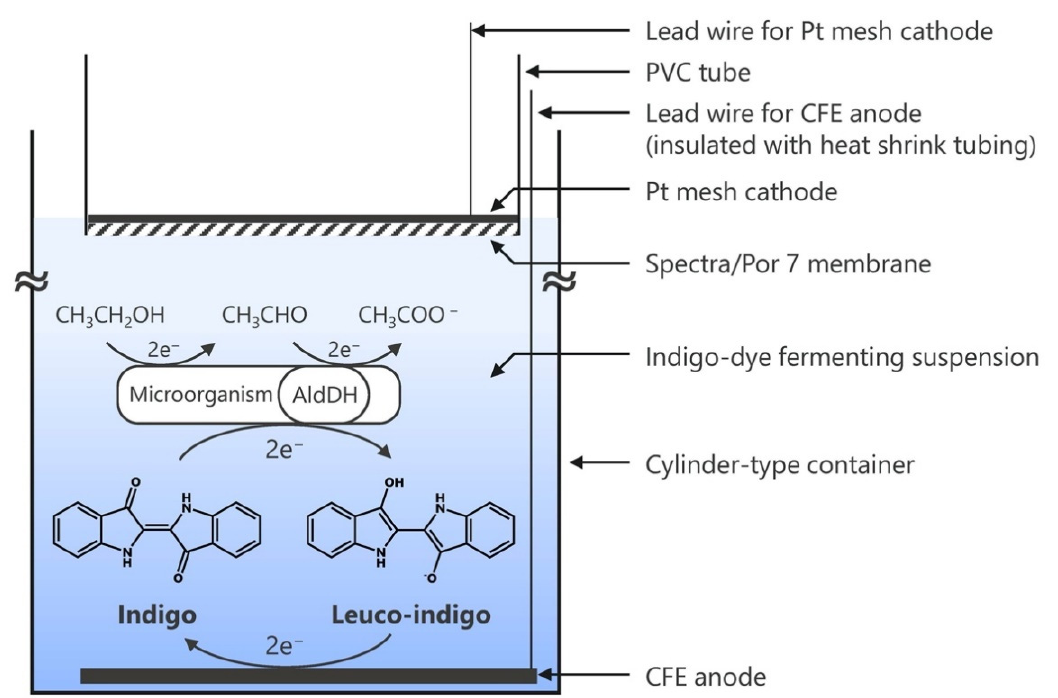
Figure 1. Proposed redox reactions and schematic of an indigo-dye fermenting suspension biofuel cell. The CFE anode was placed at the bottom of the cylinder-type container. The Pt-mesh cathode was placed at the top of the membrane. The projected surface area of the CFE anode and the Pt-mesh cathode was 0.8 cm 2 .